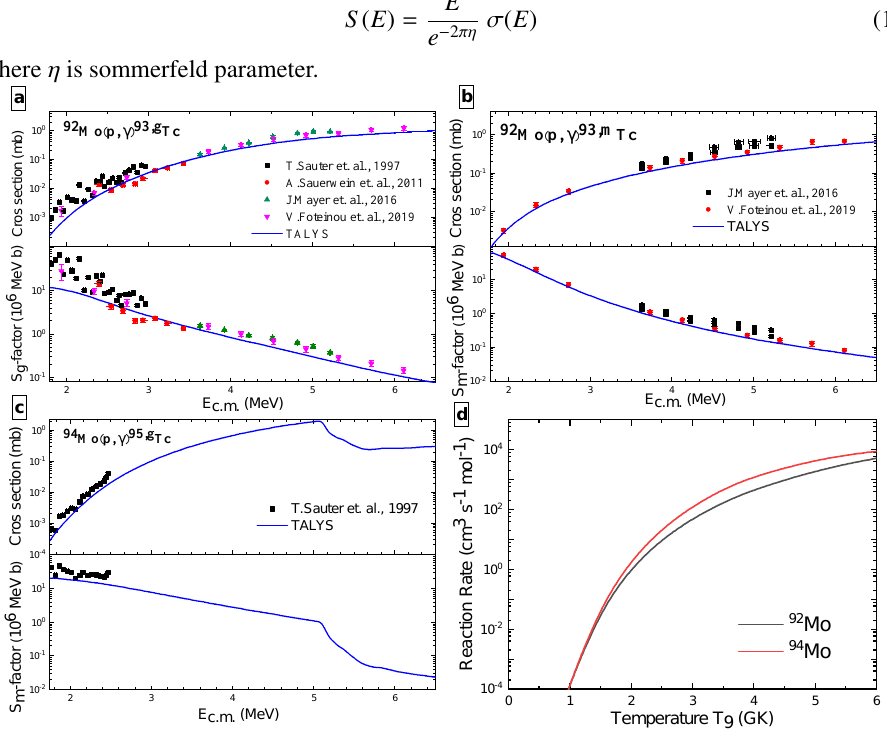
Figure 1. (Color Online) (a) Cross section and S factor for 92 Mo ( p , γ ) 93 ,g Tc , (b) Cross section and S factor for 92 Mo ( p , γ ) 93 , m Tc , (c) Cross section and S factor for 94 Mo ( p , γ ) 95 ,g Tc and (d) Comparison of reaction rate for 92 Mo and 94 Mo